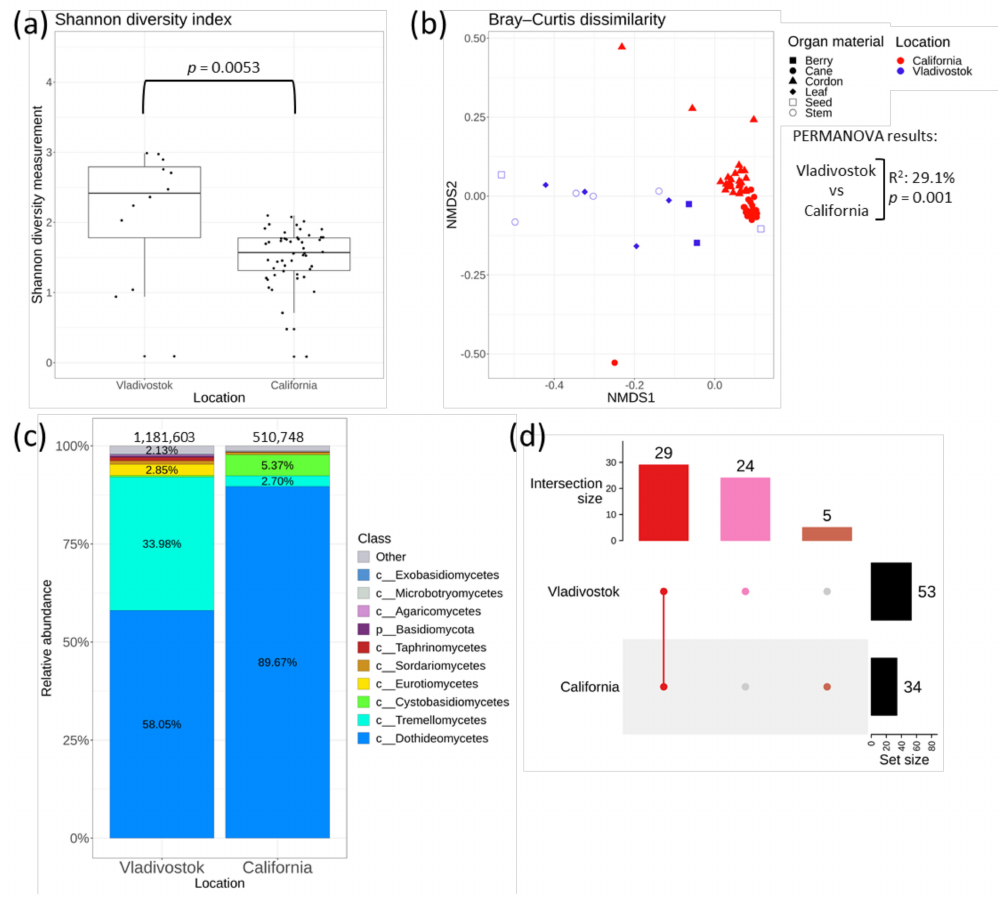
Figure 6. A comparison of endophytic fungal communities of cultivated Vitis vinifera from USA (California) with the endophytic community of Vitis amurensis from the Russian Far East (Vladivostok) ( a ) Shannon (cid:48) s alpha diversity boxplot; ( b ) Bray–Curtis beta diversity NMDS plot; ( c ) Class level taxonomical bar plots for the fungal community of V. vinifera and V. amurensis; ( d ) Genus level UpSet diagrams depicting overlapping taxa in samples. Taxa were filtered based on relative abundance of >0.1% for each biocompartment. Filtered taxa in bar plots were placed in “other” category and removed from UpSet diagram. Number of sequences are shown above taxonomical bar